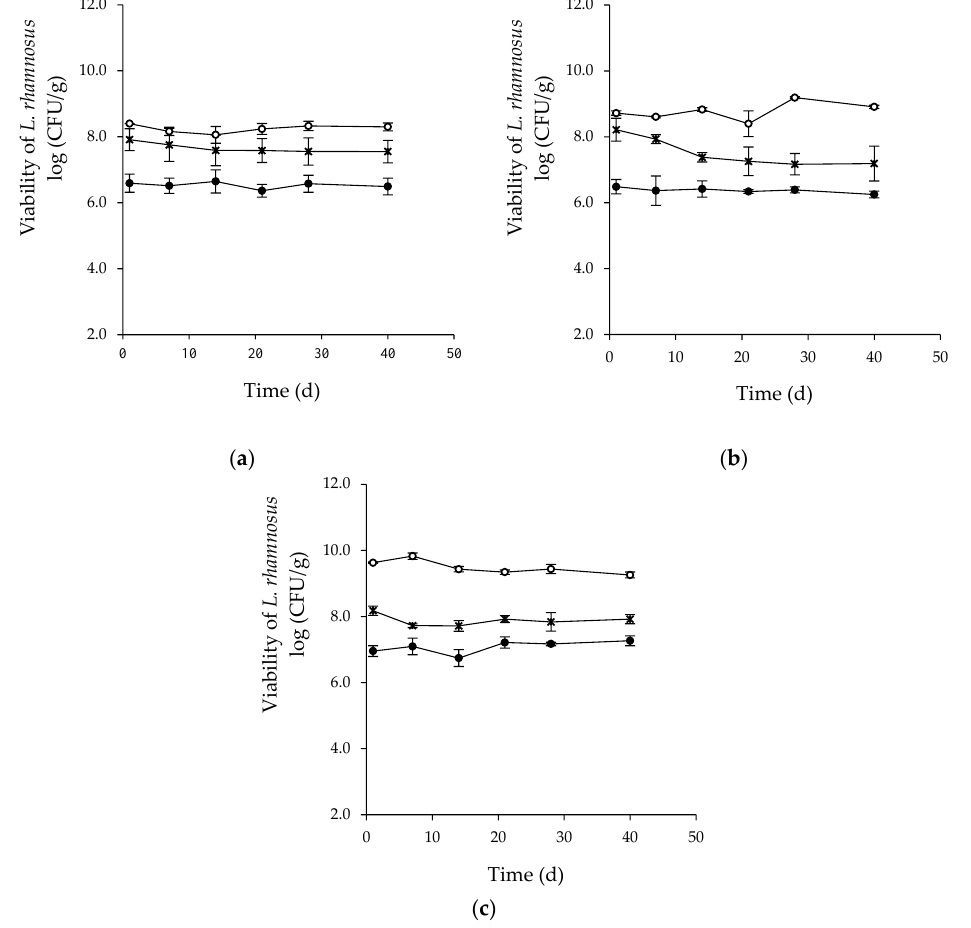
Figure 2. Viability of L. rhamnosus encapsulated by spray drying with different concentrations of chia seed mucilage (CM) during storage at 4 °C. ( a ) Control without the CM, ( b ) 0.3% w/v of CM, and ( c ) 0.6% w/v of CM. Drying inlet air temperature ( ○ ) 90 °C, (●) 110 °C, and ( ) 130 °C.